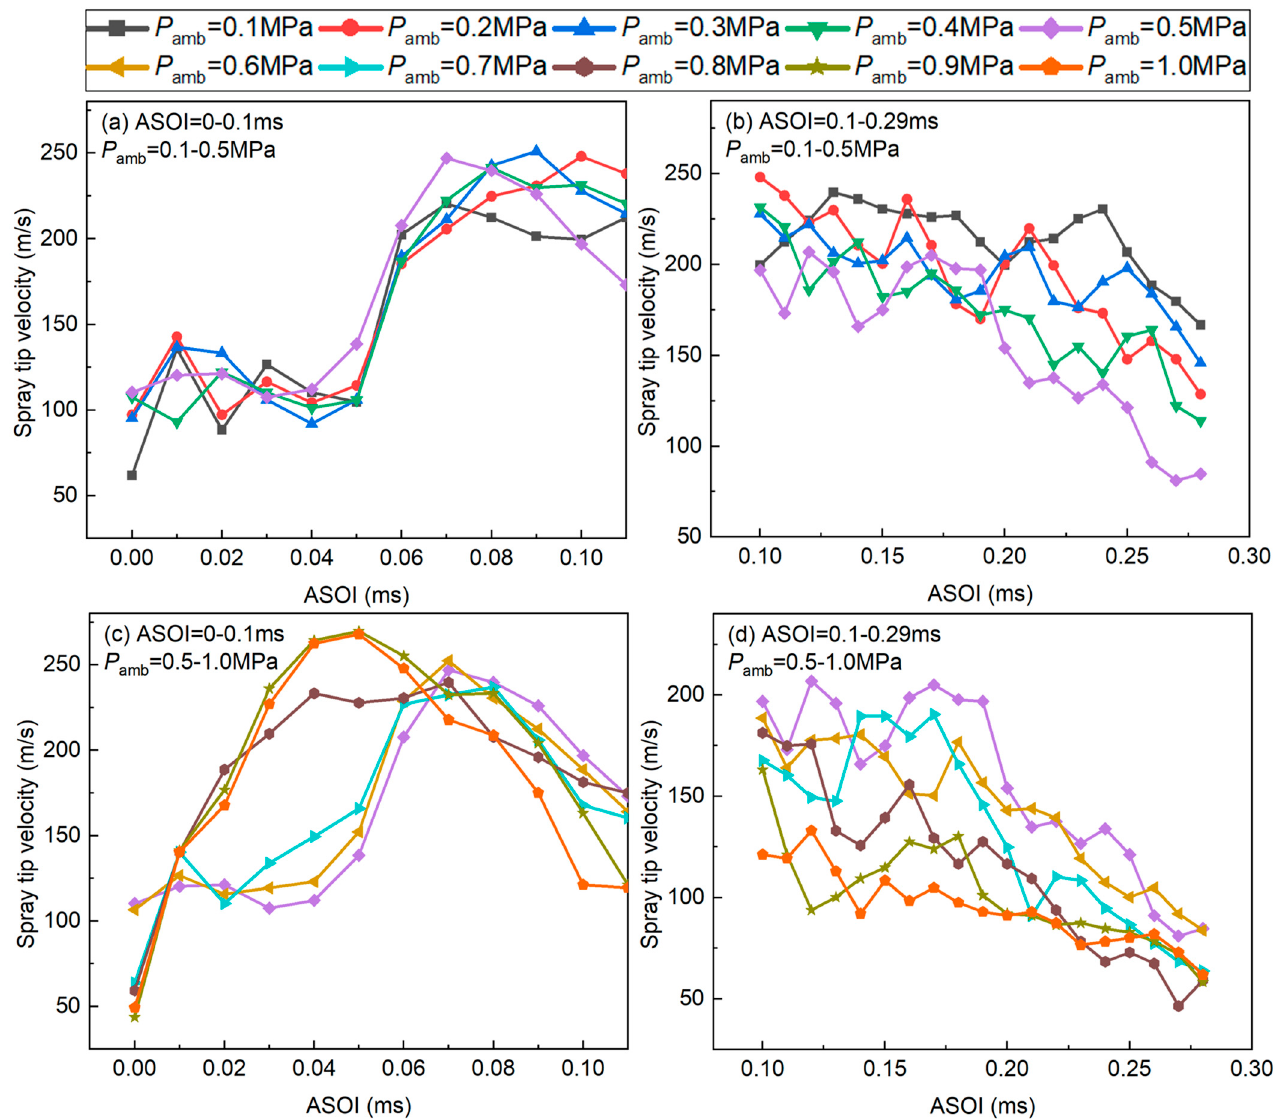
Figure 12. Spray tip velocity, P inj = 100MPa; ( a , c ) ASOI 0–0.1 ms; ( b , d ) ASOI 0.1 - 0.29 ms.